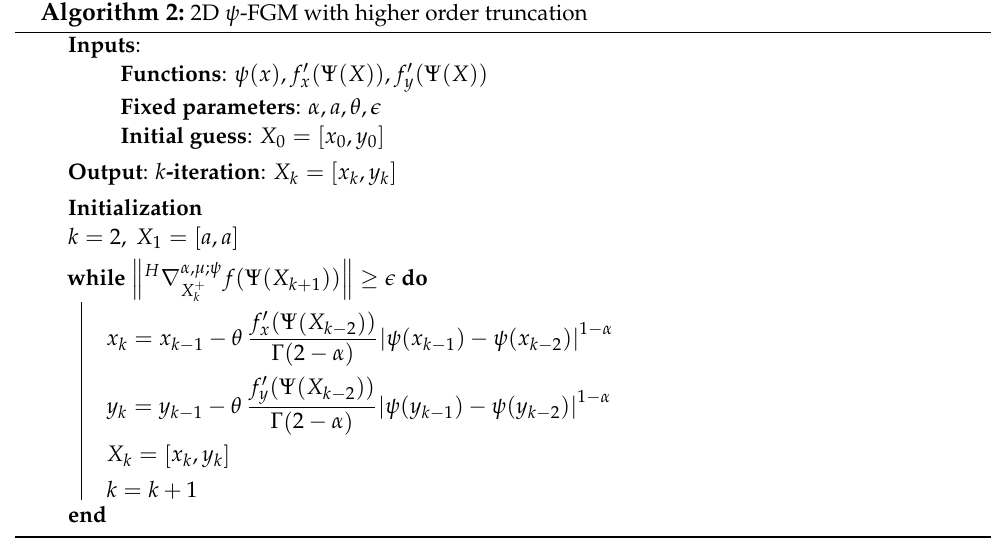
Algorithm 2: 2D ψ -FGM with higher order